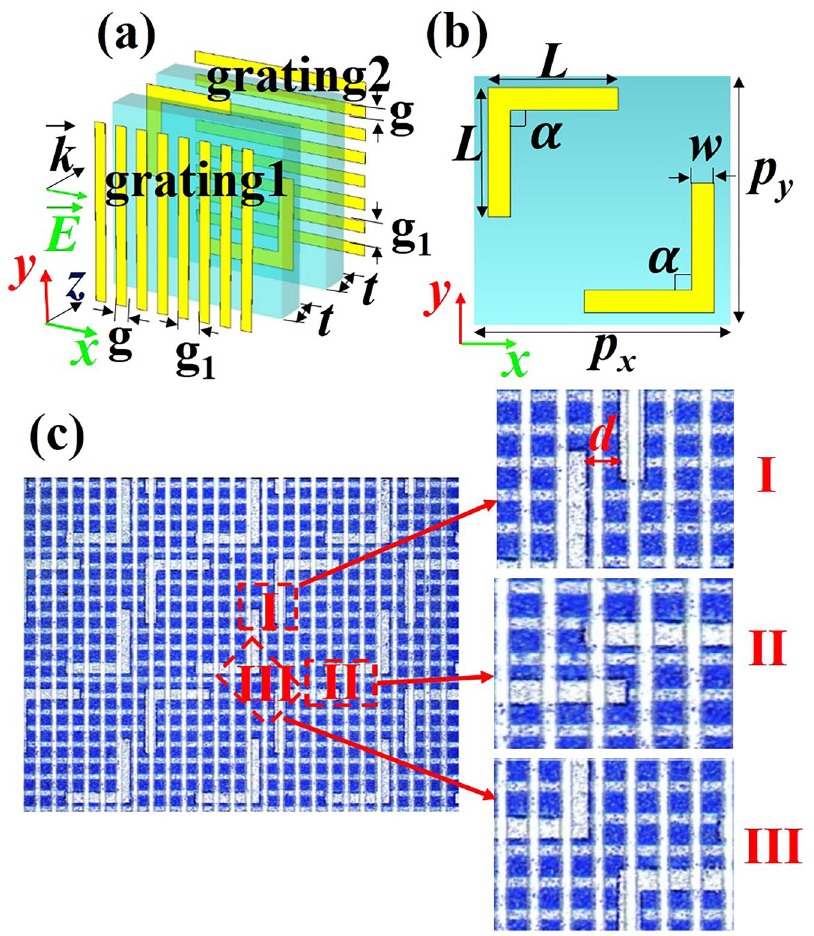
Figure 1. ( a ) Unit cell of the proposed polarization converter consisting of two gratings, a double L -shaped metasurface, and two dielectric plates. ( b ) Front view of the metasurface unit cell. ( c ) Optical image of the fabricated sample. The geometric parameters are t = 75 µ m, g = 25 µ m, g 1 = 50 µ m, p x = p y = 400 µ m, L = 200 µ m, w = 35 µ m, and α = 90°. The periodic lattices are along the x and y directions, and the EM waves propagate along the z direction. The regions I, II and III, surrounded by the square frame, denote the EM mutual coupling areas of a unit cell with neighboring unit